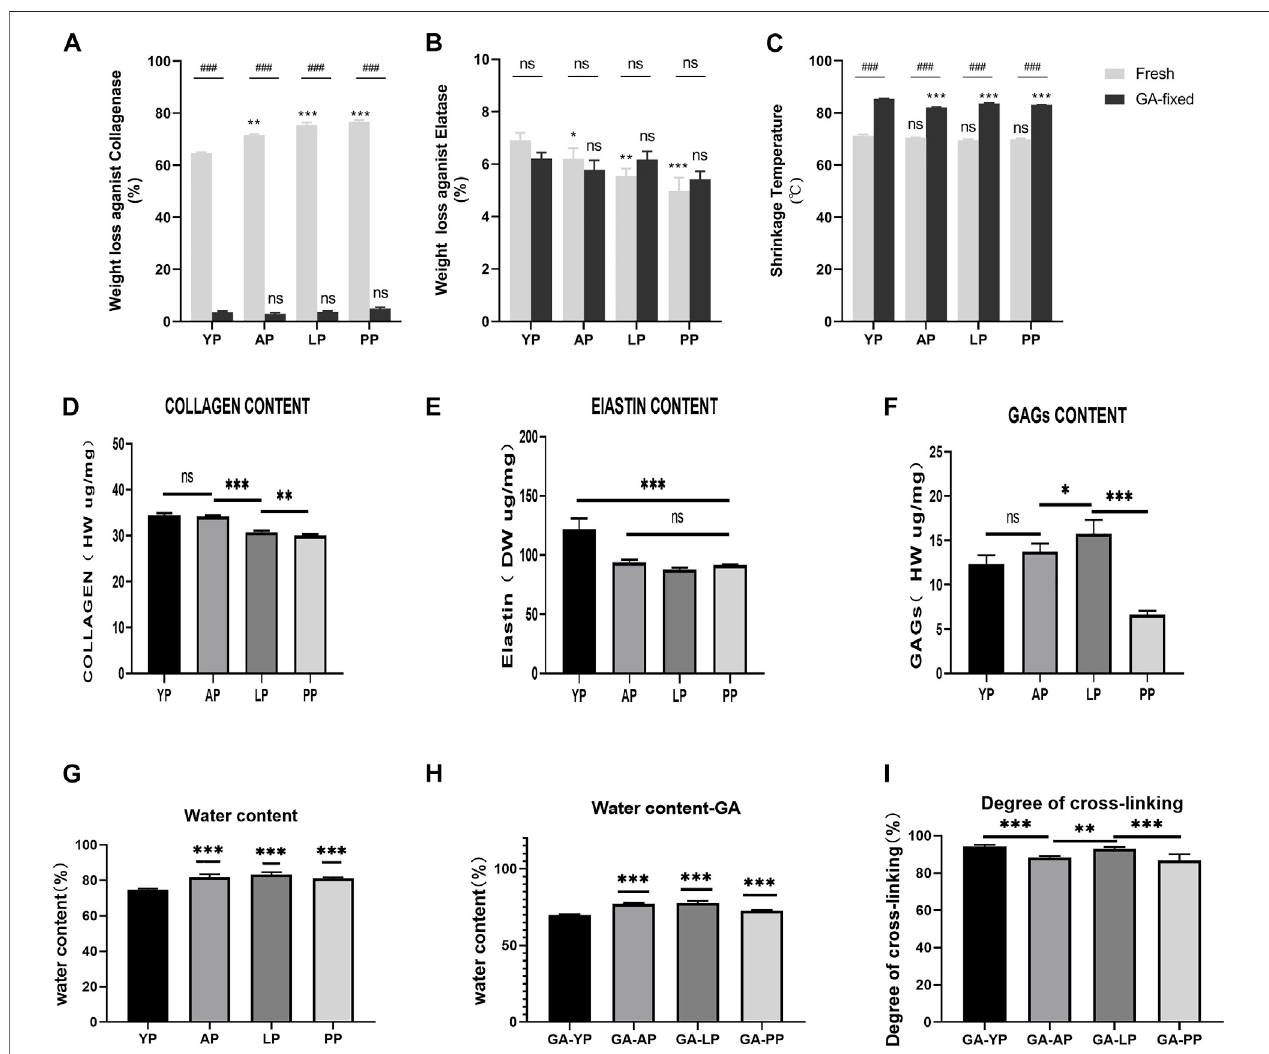
FIGURE 2 | Enzymatic degradation and Thermal stability. (A) , Fresh and GA-crosslinked pericardium weight loss against collagenase; (B) , Fresh and GA- crosslinkedpericardiumweightlossagainstElatase; (C) ,FreshandGA-crosslinkedofshrinkagetemperature.Enzymaticdegradation :( n (cid:2) 6,* p < 0.05;** p < 0.01;*** p < 0.001; ns represents no signi fi cant difference). Thermal stability: ( n (cid:2) 8,* p < 0.05; ** p < 0.01;*** p < 0.001; ns represents no signi fi cant difference) Evaluation of water content,degree of cross-linking, collagen, elastin, and GAGs of fresh and glutaraldehyde cross-linked pericardium. (D) , collagen content of fresh pericardium; (E) , elastin content of fresh pericardium; (F) , GAGs content of fresh pericardium. (G) , water content of fresh pericardium; (H) , water content of GA-crosslinked pericardium; (I) , degree of GA-crosslinked pericardium. ( n (cid:2) 6; * p < 0.05; ** p < 0.01;*** p < 0.001; ns represents no signi fi cant difference)